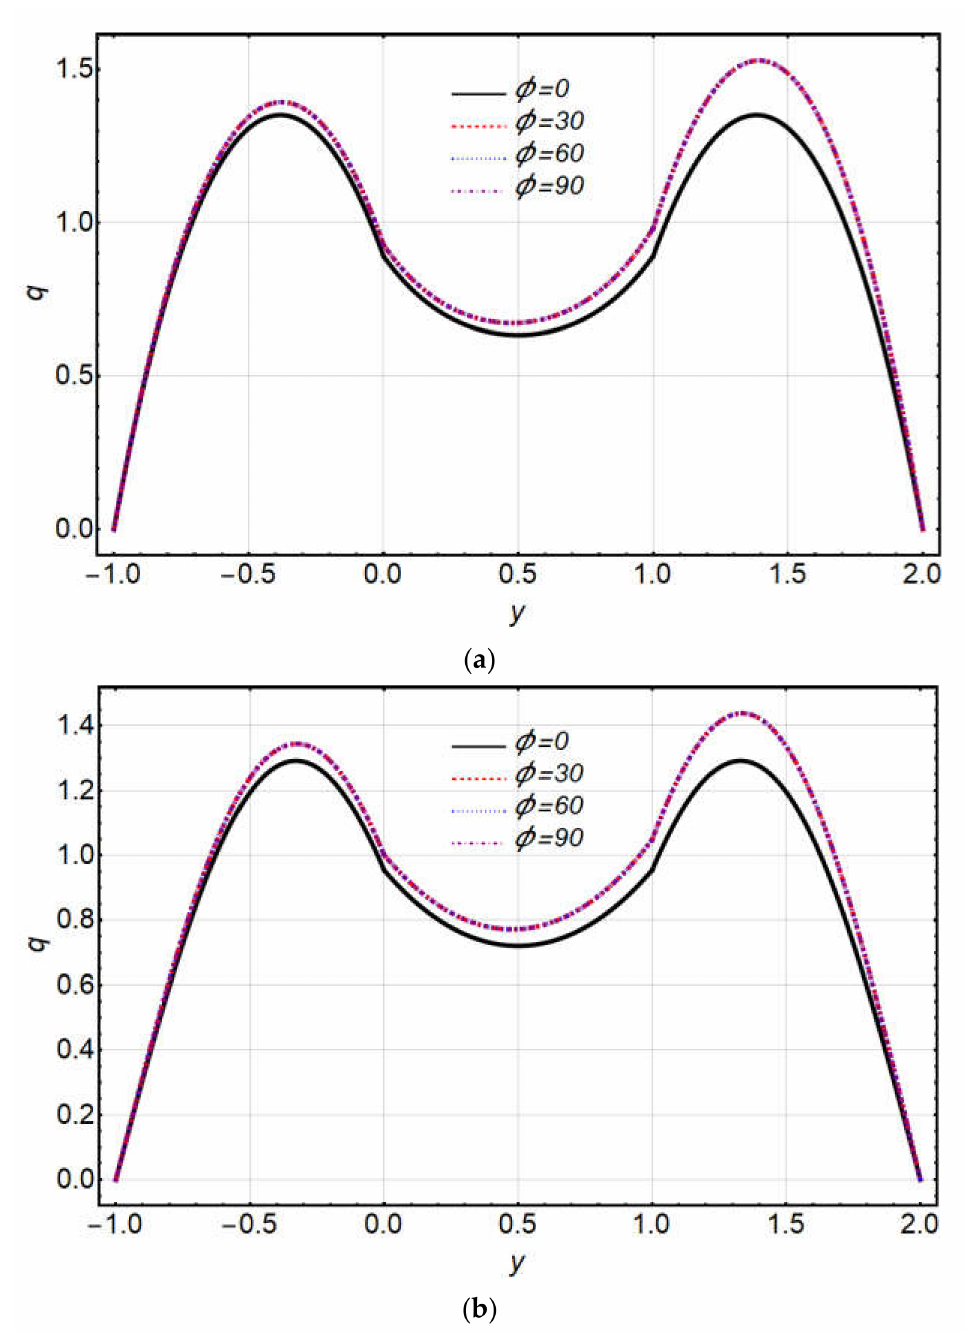
Figure 6. Velocity distribution of φ : ( a ) axial, ( b )